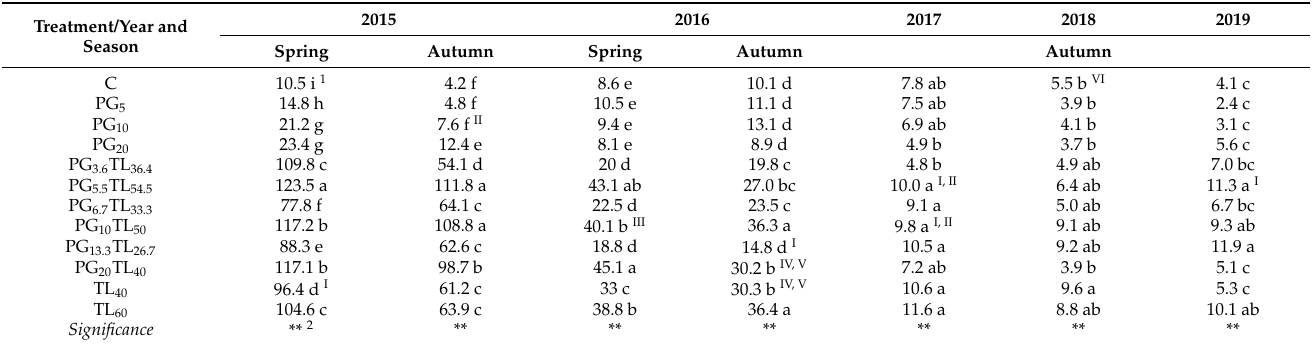
Table 11. Effect of treatments and years on the content of nitrate nitrogen (NO 3 − -N, mg kg –1 ) at 0–20 cm soil layer.